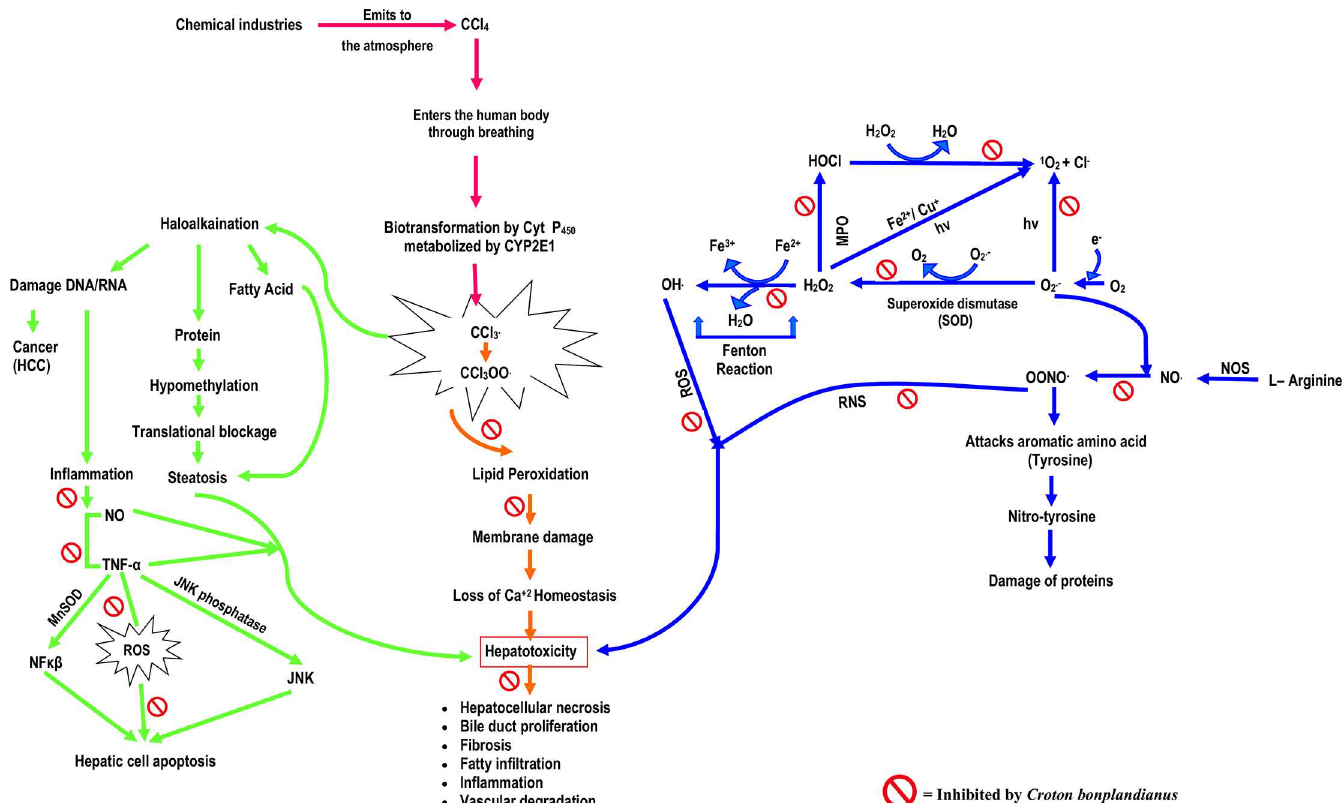
Fig 15. Schematic representation showing the free radical generation followed by the chain of by-product (ROS/RNS) formed due to oxidative stress and how they affect biological systems by cellular stress and CCl 4 induced hepatotoxicity. The pathway demonstrates the mechanism of CCl 4 induced hepatotoxicity which is predominantly mediated by oxidative stress and inflammatory injury due to the formation of reactive metabolic intermediates and the free radical formation cascade during xenobiotic induced hepatotoxicity causing oxidative and nitrosative stress. Cyt P450 = cytochrome P450, CCl 3 • = trichloromethyle radical, CCl 3 OO • = trichloromethylperoxy radical, TNF- α = tumor necrosis factor- α ,; HOCl: Hypochlorous acid; H 2 O 2 : Hydrogen peroxide; 1 O 2 : Singlet oxygen; O 2.- : Superoxide; OH . : Hydroxyl radical; 8-OHdG: 8-hydroxy2-deoxy guanosine; OONO - : Peroxynitrate; NO . : Nitric oxide; Fe 2+ : Iron ion; Cu + : Copper ion; Cl - : Chlorine ion; ROS: Reactive oxygen species; RNS: Reactive nitrogen species; NOS: Nitric oxide synthase; MPO: Myeloperoxidase; MDA: Malondialdehyde.